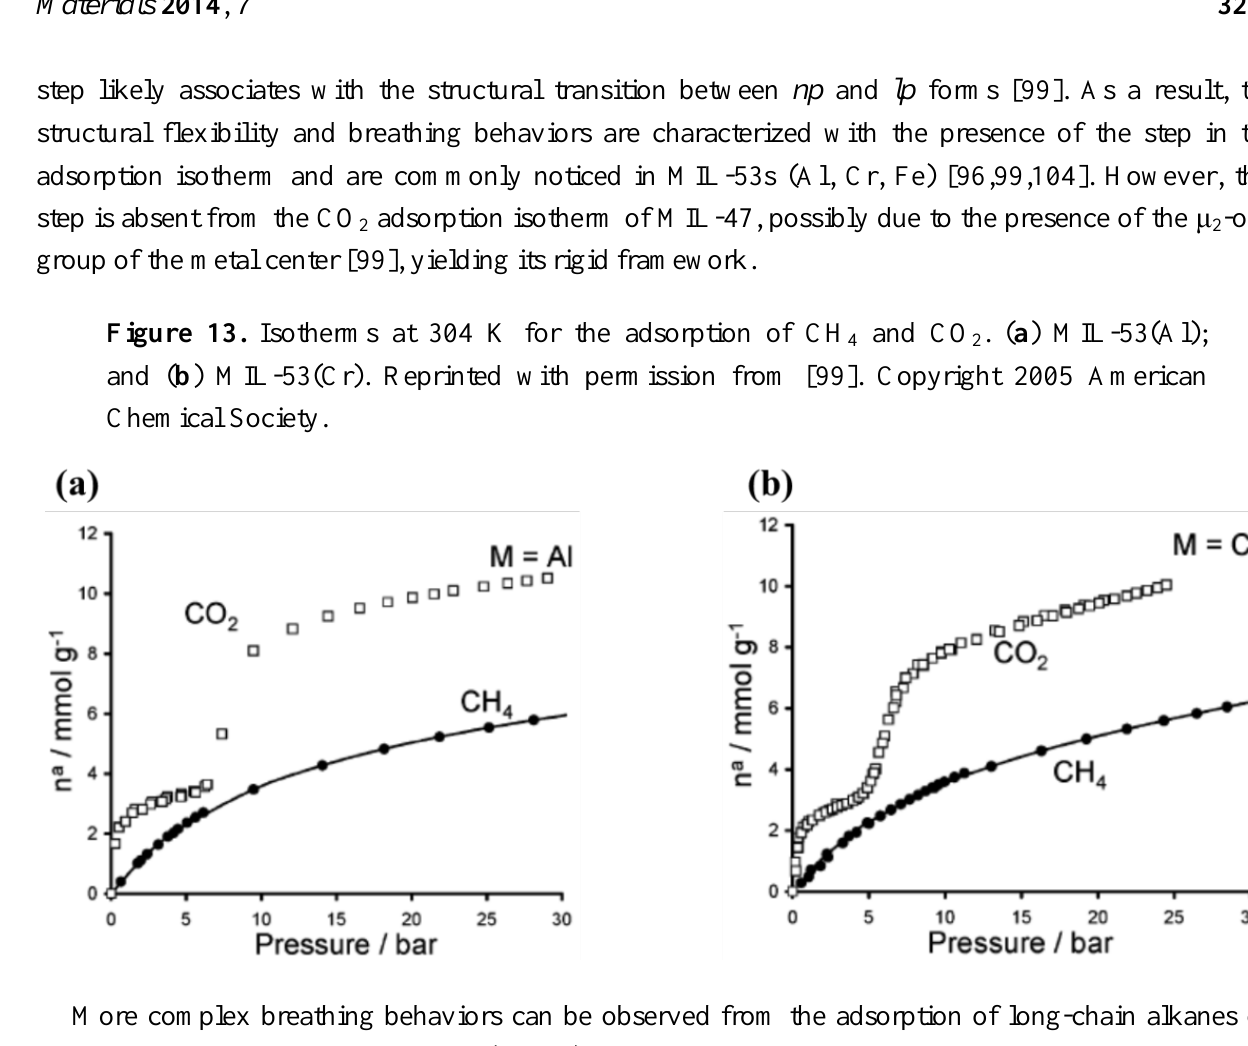
and CO . ( a ) MIL-53(Al); 4 2